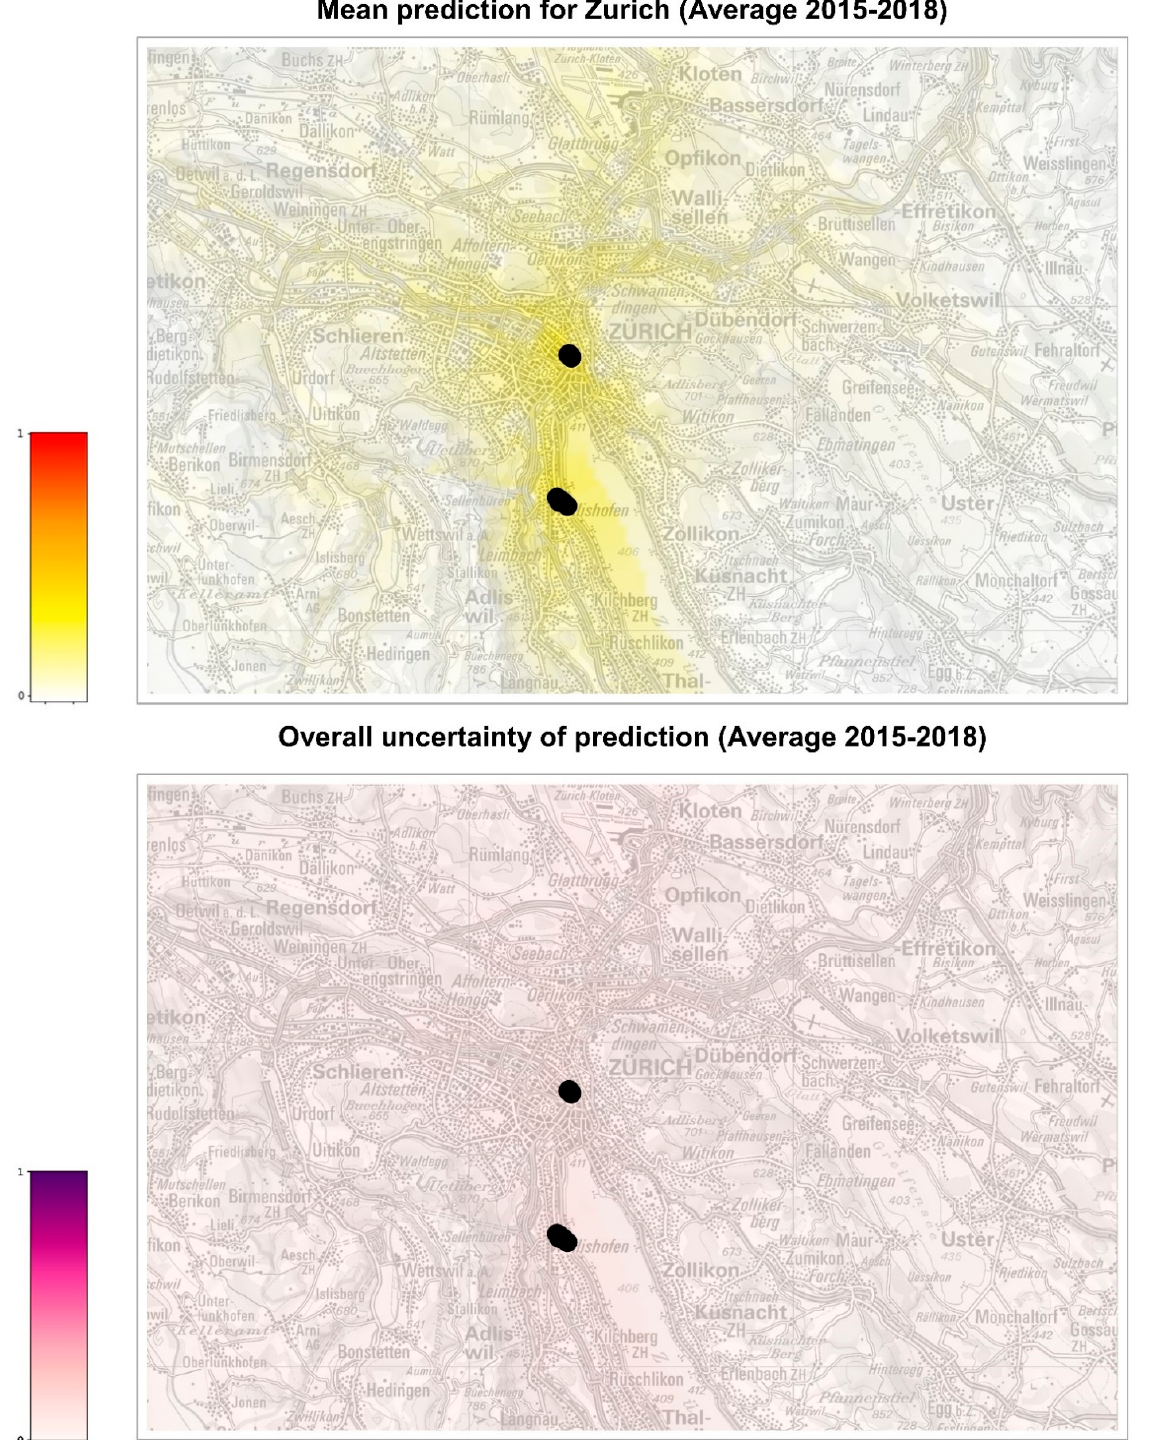
Figure 5. Probabilities of establishment of Ae. albopictus in Zurich. The map on top shows the average risk estimate over the years 2015–2018. The color gradient shows the probability of establishment from 0 (white) to 1 (red). The bottom map represents the uncertainty of the prediction (higher values representing more uncertain predictions). Black dots show the positions where Ae. albopictus was established in 2019, which are used to compute the feature car distance to establishment (distance from the closest cell with establishment in the previous year). Maps modified from https://map.geoadmin.ch/ (accessed on 24 February 2022).